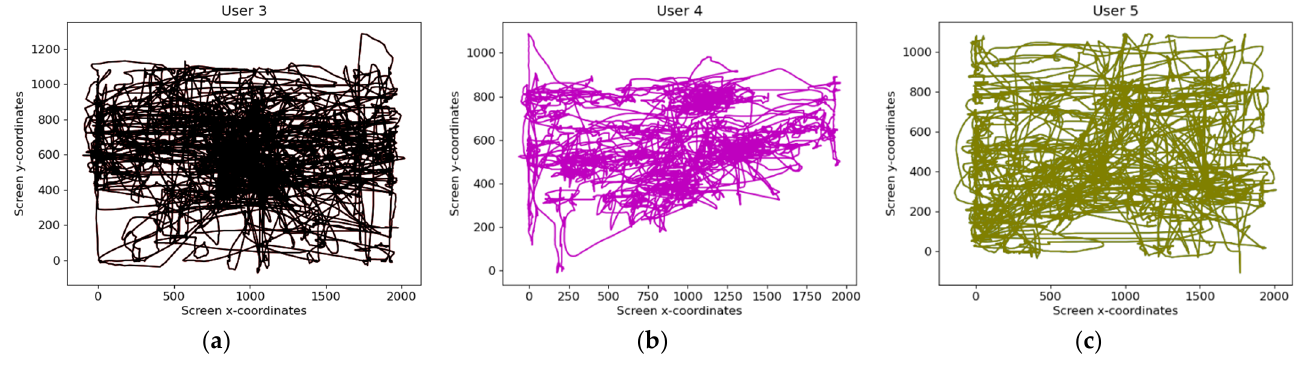
Figure 1. ( a ) Visualization of raw mouse from User 3’s session; ( b ) visualization of raw mouse from User 4’s session; and ( c ) visualization of raw mouse from User 5’s session.